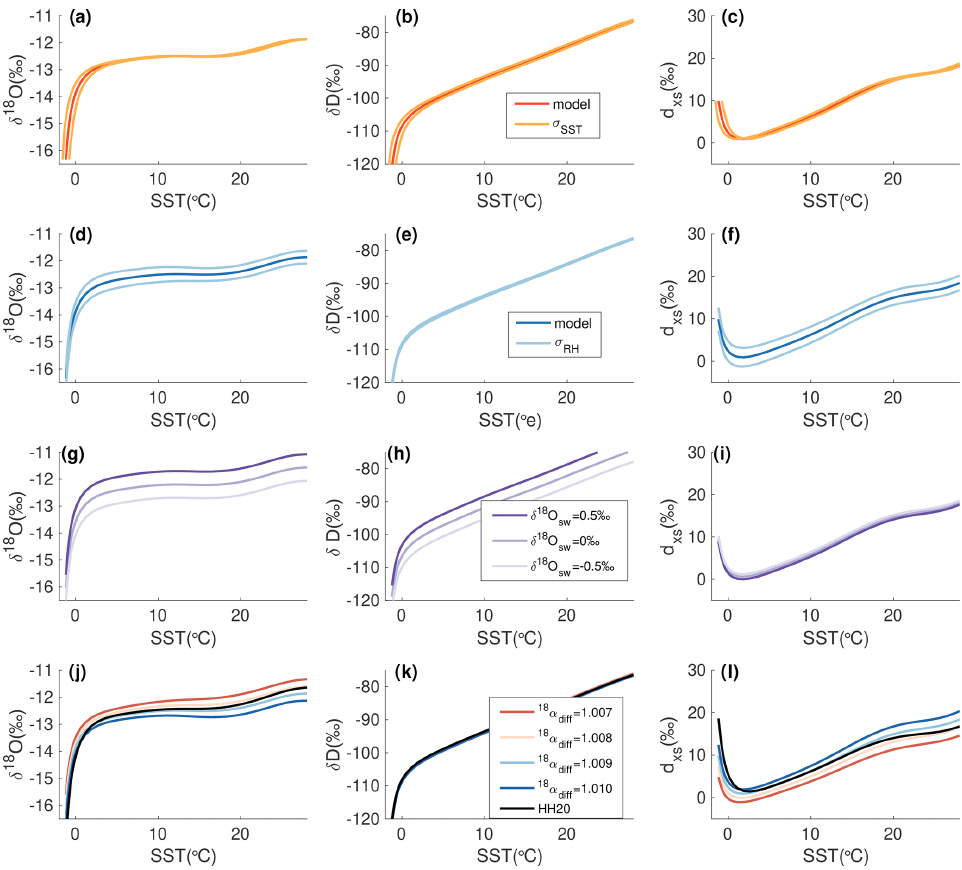
Figure A5. (a–f) Sensitivity of modeled δ 18 O, δ D, and d xs of vapor to uncertainty in the reanalysis-based fits between climatological T a , SST, and RH in the NCEP/NCAR reanalysis. Panels (a) and (b) show the modeled isotope vapor relationship to uncertainty in the climatological T a -to-SST relationship. Red lines show the model run using the central estimate of the fit, and orange lines show the spread expected with ± σ err of the fit as shown in Fig. A1. Panels (c) and (d) are the same as (a) and (b) but showing the central estimate (dark blue) and spread associated with ± σ err (light blue) in the climatological T a -to-RH relationship shown in Fig. A1. (g–i) Sensitivity of modeled isotope values of vapor to the δ 18 O sw of seawater. Values of δ 18 O sw from − 0 . 5‰ to 0.5‰ are specified, representing most of the global variance in δ 18 O sw . Values of δ D sw are determined based on correlations of δ 18 O sw and δ D sw from observations (Schmidt et al., 1999). (j–l ) Sensitivity of modeled isotope values of vapor to a range of 18 α diff values from 1.007 to 1.010. Also shown are results using the first-principles-based diffusivities of Hellmann and Harvey (2020) (HH20, black, using n = 0 . 27 in Eq. A4). Local closure is assumed in all